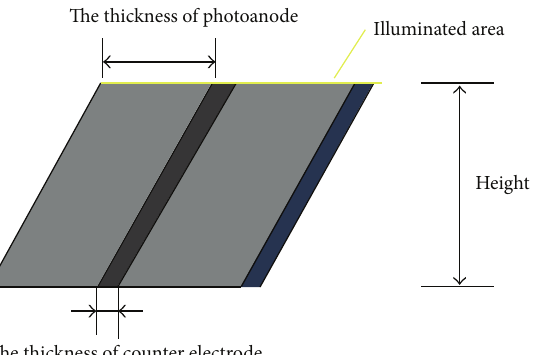
parameter for the simulation of sunlight is AM1.5, with a 100 mW/cm 2 light.